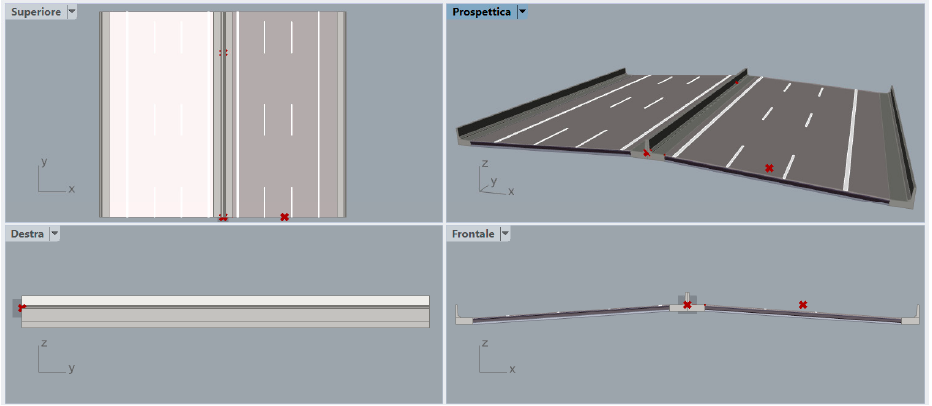
Figure 6. Road type freeway Type A as a result the procedural model.